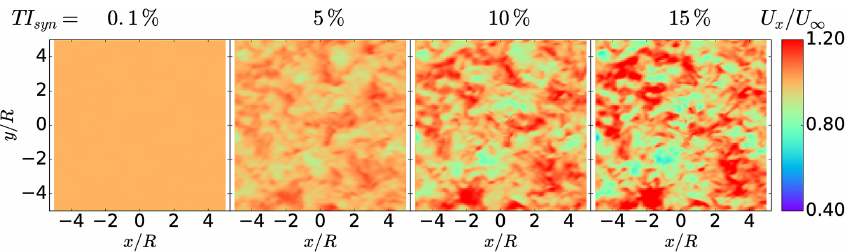
Figure 2. Midplane at z/R = 0 of the instantaneous normalized axial velocity component U x /U ∞ showing homogeneous isotropic turbu- lence for different turbulent intensities TI syn in the numerical